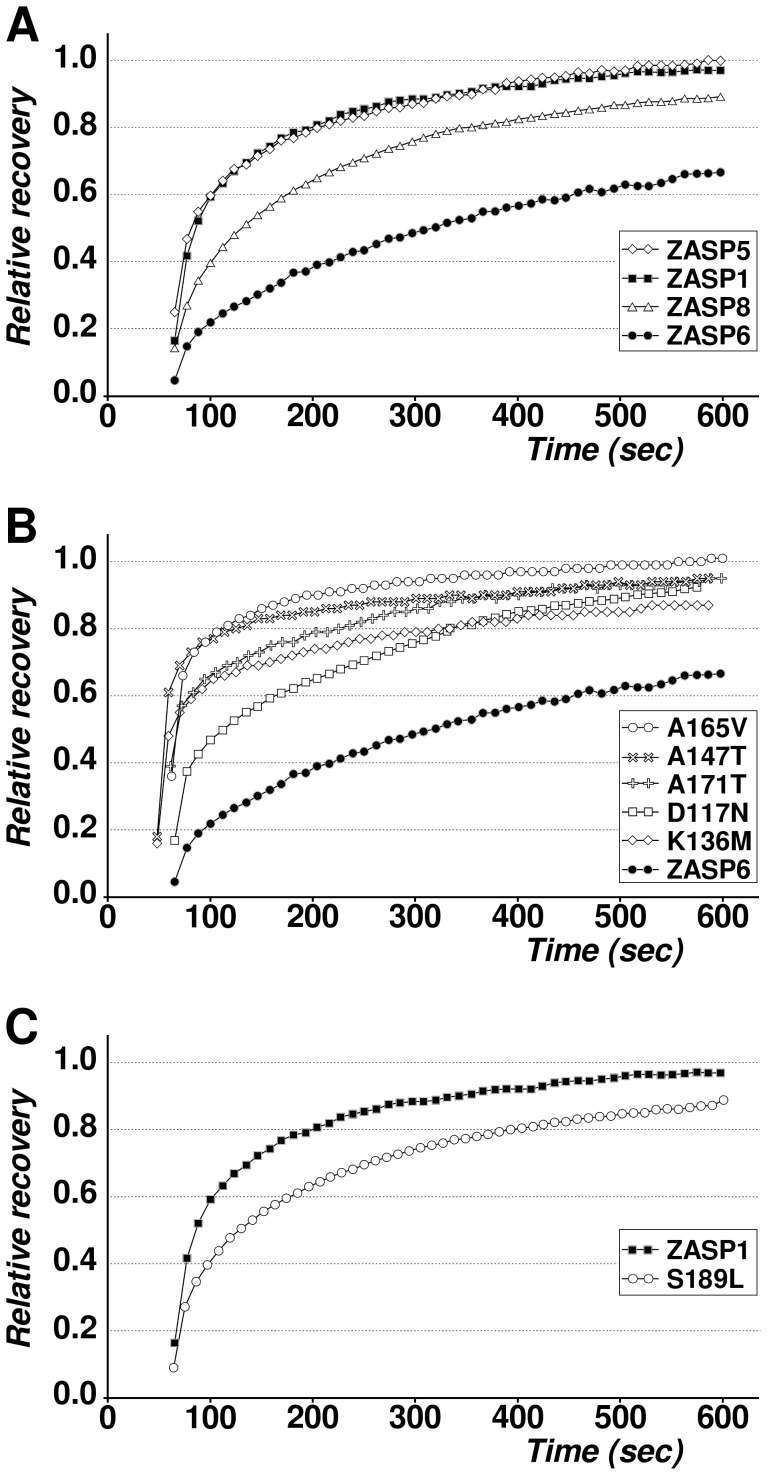
FRAP analysis of human isoforms of ZASP and their mutants.The recovery times were measured every 10–12 sec, within 10 min after bleaching (50 points). The relative FRAP recovery was plotted as a function of time. A) FRAP analysis of ZASP isoforms, 1 (black squares), 5 (white diamonds), 6 (black circles) and 8 (white triangles). B) FRAP analysis of human ZASP6 (black circles) and its mutants ZASP6_K136M (white diamonds), ZASP6_D117N (white squares), ZASP6_A171T (white cross), ZASP-6_A147T (white saltire cross), ZASP6_A165V (white circles). C) FRAP analysis comparing the ZASP1 wt (black square) and ZASP1 mutant S189L (white circles).